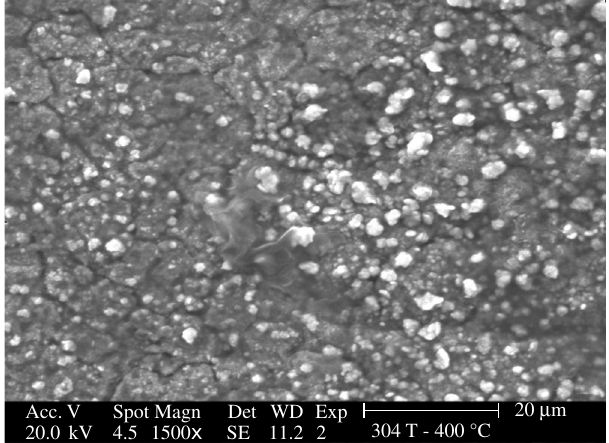
Figure 9. Samples of the AISI 444 ferritic stainless steel treated at 200 °C, no indication of corrosion.